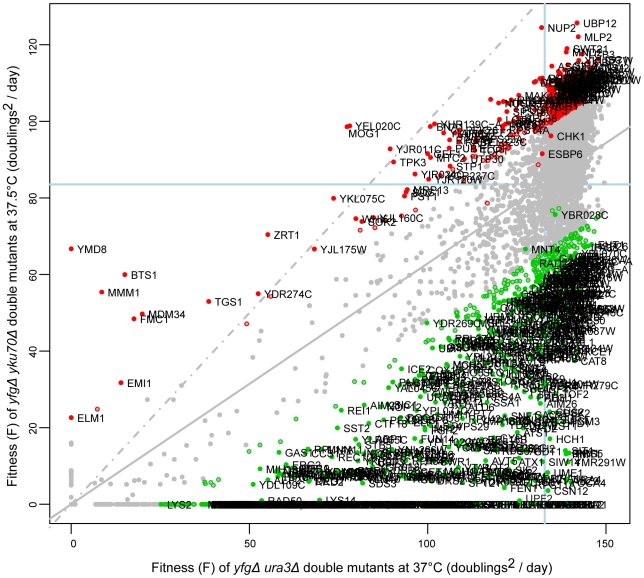
Fitness of yku70Δ strains at high temperature.The yeast genome knock out collection was crossed to the yku70Δ mutation, or as a control to the ura3Δ mutation. 8 replicate crosses were performed and for each, the fitness of all double mutant cultures measured as in Figure 1. Growth of yku70Δ yfgΔ (“your favourite gene deletion”) double mutants was measured at 37.5°C and ura3Δ yfgΔ strains at 37°C. Gene deletions that significantly enhance (green) or suppress (red) the yku70Δ defect, in comparison with the ura3Δ mutation are indicated. Those marked by open circles have p-values <0.05 and those filled circles have FDR corrected p-values (q-values) <0.05. The line of equal growth (dashed grey) and a population model of expected fitness (solid grey) are indicated. The average position of his3Δ strains are indicated by solid light-blue lines on each axis, as proxy for “wild-type” growth.